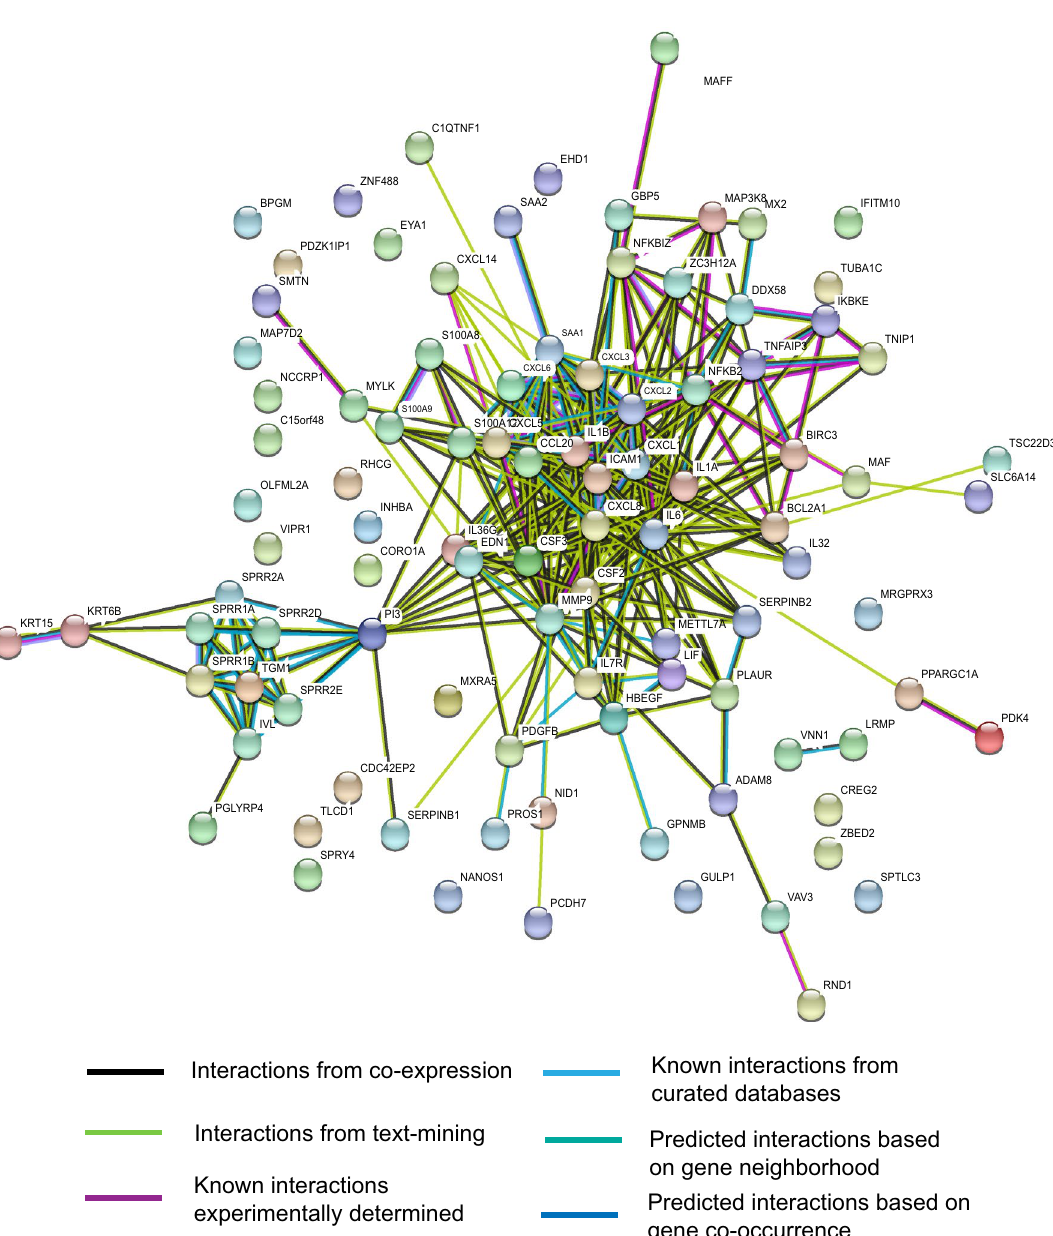
Figure 3. Protein–protein interaction network of genes altered by SARS-CoV-2 infection. The network with 333 edges among 72 nodes was obtained from the STRING database. Interactions with scores of ≥ 0.4 were